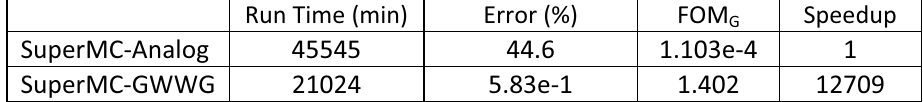
Table II. Comparison of GWWG and Analog calculation results of the global reaction rate